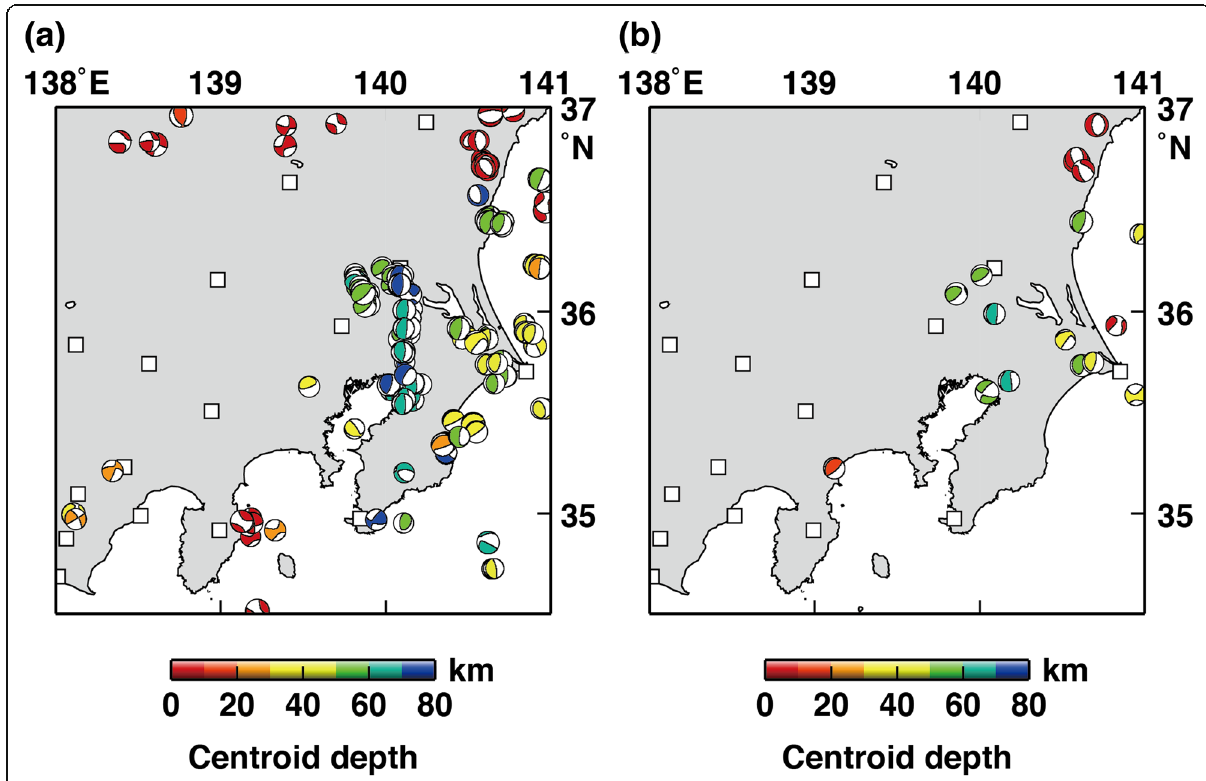
Fig. 2 Distribution of the CMT solutions used in the present study for ( a ) adjoint inversion and ( b ) the validation of the inversion results. The beach ball color corresponds to the centroid